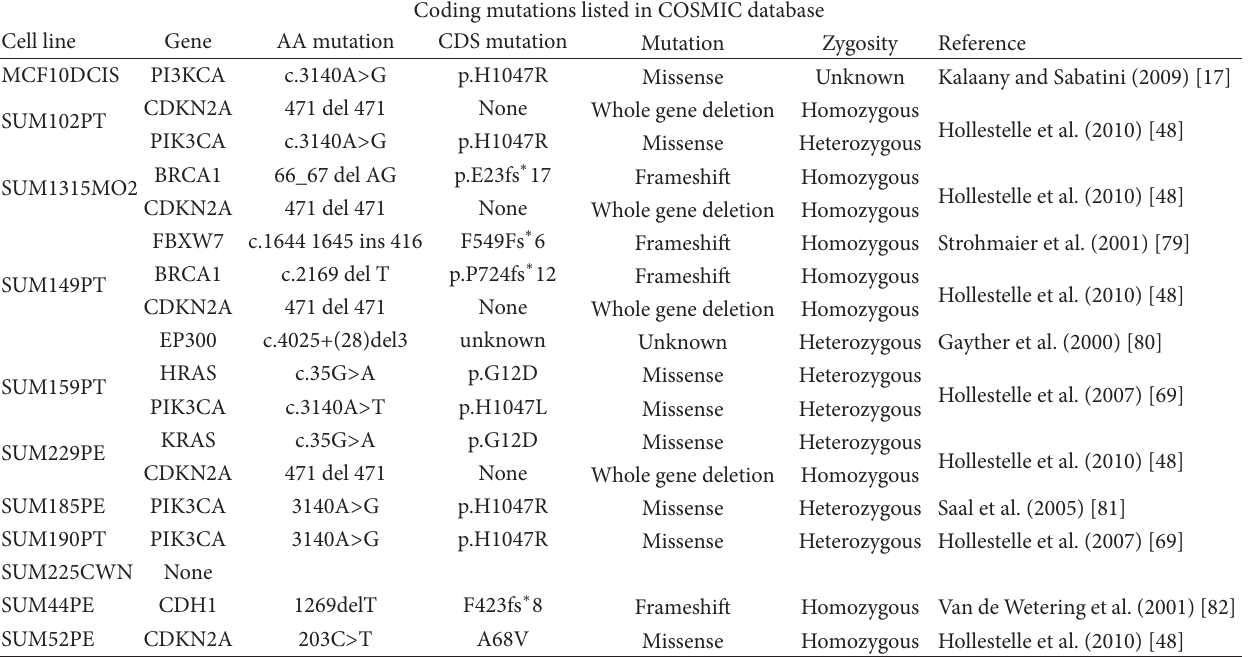
T 7: Summary of mutations affecting the coding sequence of Asterand breast cancer cell lines. Coding mutations listed in COSMIC